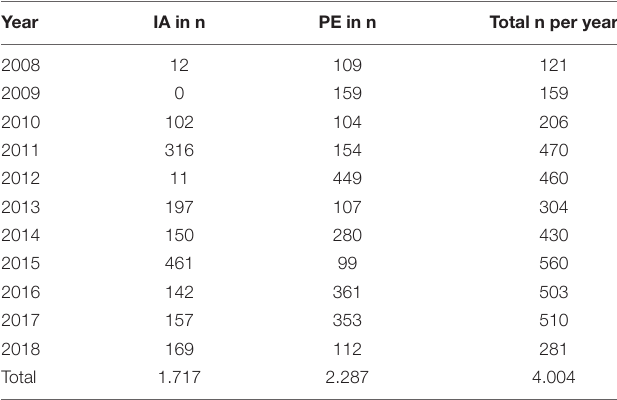
TABLE 3 | TA sessions done per year.